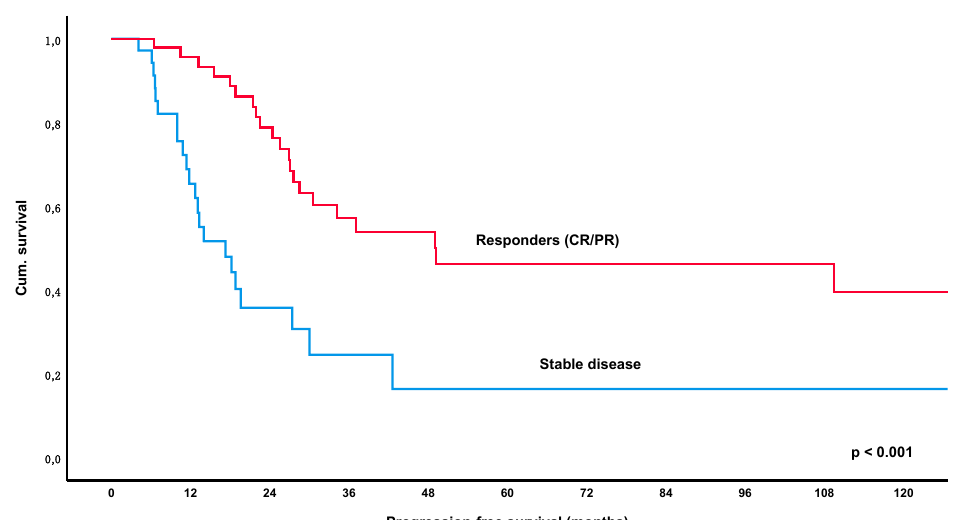
Figure 4. Kaplan-Meier curve for progression-free survival following first line Helicobacter pylori eradication, comparing patients with an objective response (=partial or complete remission) versus stable disease. Abbreviations: CR = complete remission, PR = partial remission.